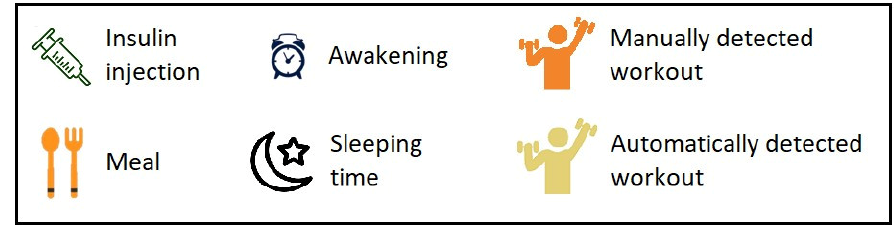
Figure 6. Legend of the additional events related to the patient’s lifestyle.